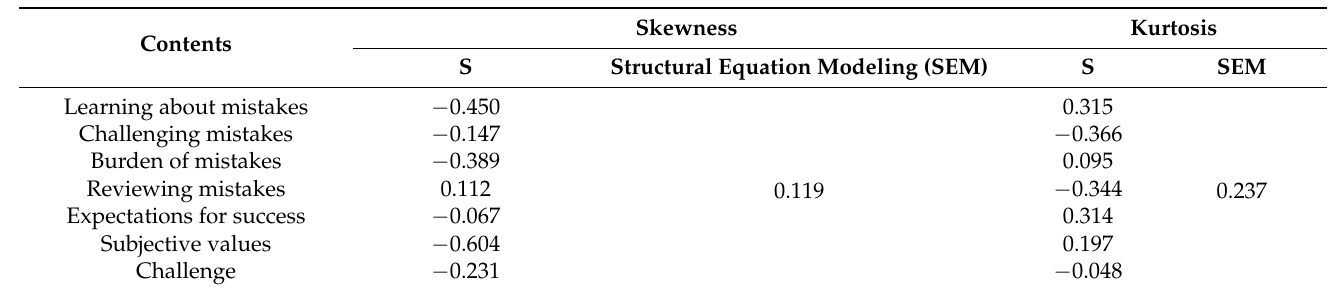
Table 3. Normality test.